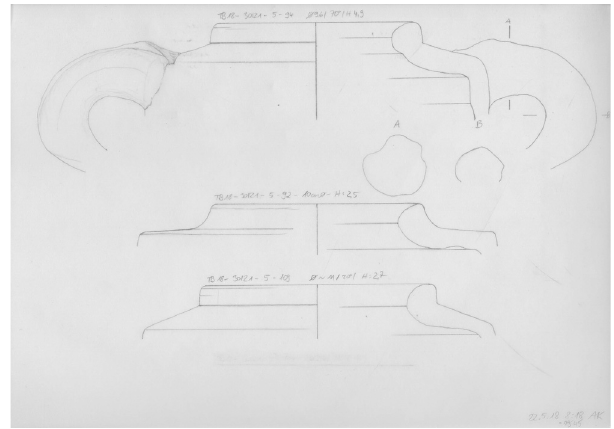
Figure 3: Scan of fi nished pencil drawings ( original format of the paper sheet is DIN A4 )